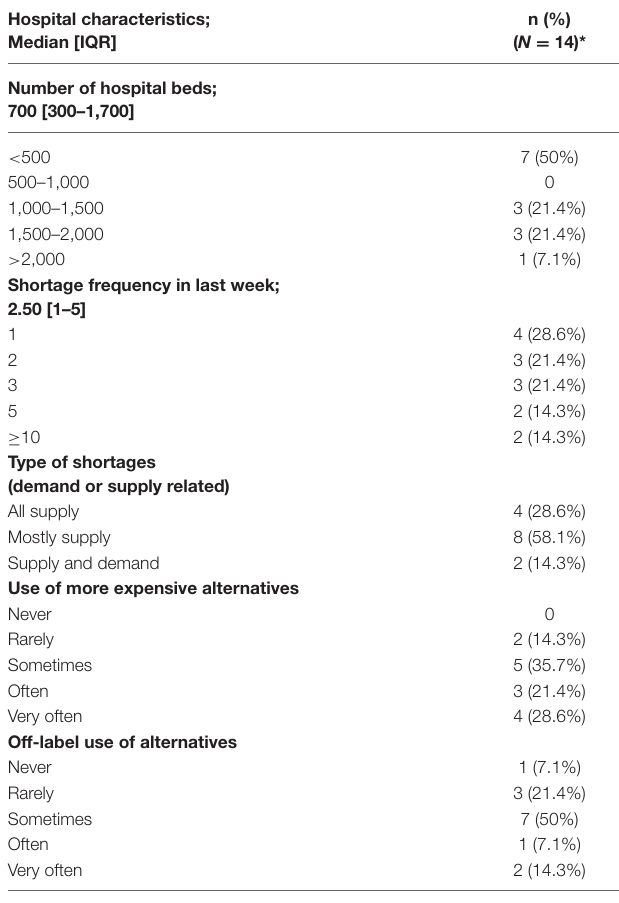
TABLE 1 | Interviewees’ hospital